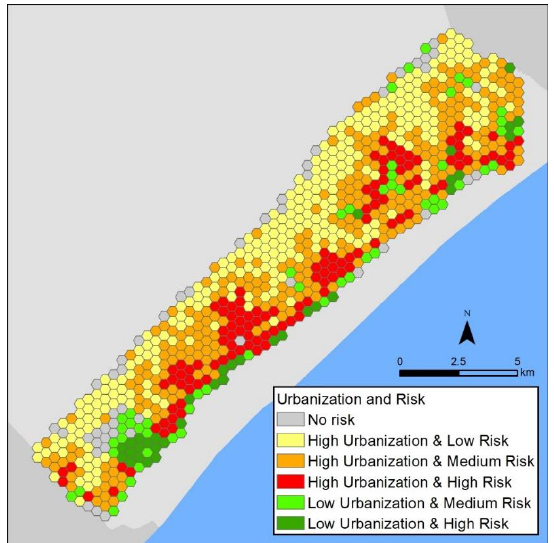
Figure 14. Urbanization (percent) compared with risk: places with at least 25% development (2016) or increasing development (slope greater than 0.1) of medium risk (orange) or high risk (red) and places with low development (less than 25 percent) of medium (light green) or high risk (dark green).